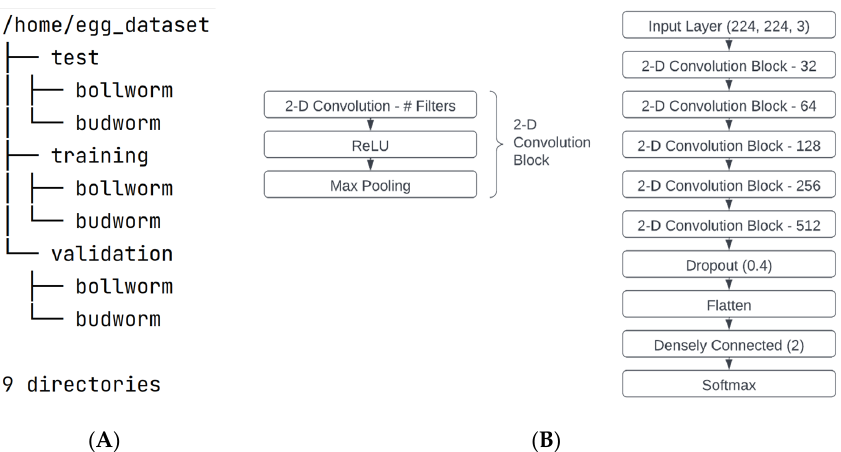
Figure 3. ( A ) Tree structure representing the overall data organization, i.e., training, validation, and testing for bollworm and budworm classes. ( B ) The multilayer convolutional network architecture. The first layer of the first convolution block accepts a 224 × 224 × 3 tensor input, which is convolved with a 3 × 3 filter kernel that extracts pixel-wise features before down-sampling the array by a factor of two along the y and x dimensions with a max pooling layer. Five sequential convolution blocks, each with an increasing number of kernels of the same size, extracts features at different spatial scales. A dropout layer randomly excludes 40% of the input connections before the resulting array is flattened into a 1-dimensional vector and passed to a dense connection layer with two output classes. Final outputs are activated using a softmax function, while outputs from the convolution layer of each block are activated using a ReLU function.